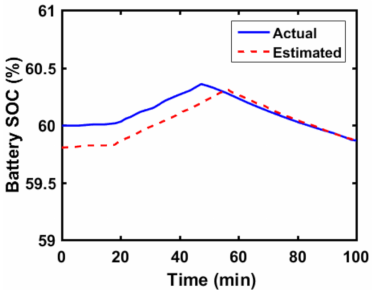
Figure 13. Training, Testing, and Validation results with regression.